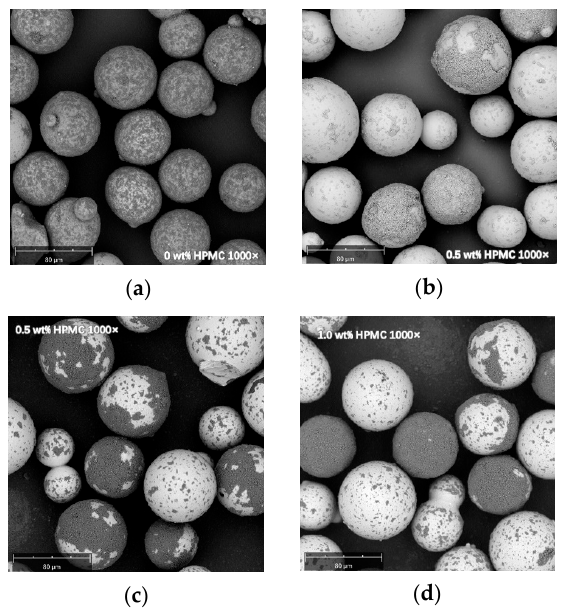
Figure A3. SEM images from experiments using various HPMC mass fractions of the coating solution